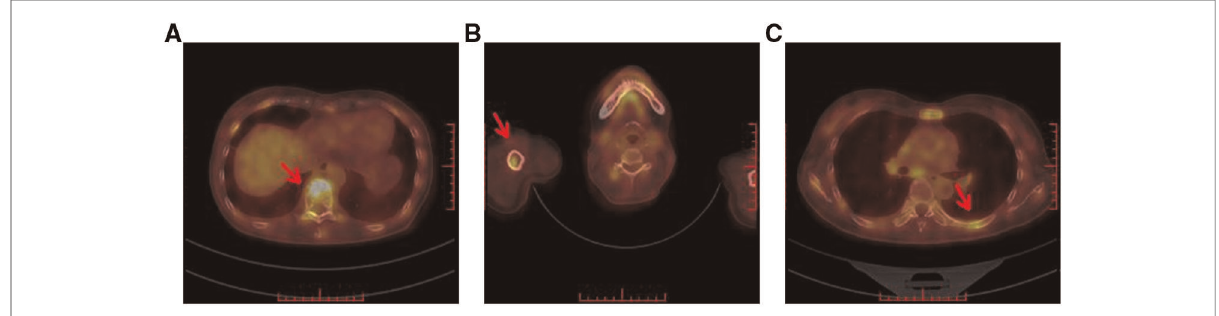
FIGURE 5 Breast molecular imaging fi ndings from a 50-year-old woman with invasive ductal carcinoma with micropapillary features diagnosed with distant bone metastases. PET/CT images show the diffusely increased uptake of 18 F-FDG in the following areas: ( A ) in the spine; ( B ) in the right humerus; and ( C ) in the left ribs (red arrows indicate the locations of metastatic lesions). Abbreviations: PET, positron emission tomography; CT, computed tomography; 18 F-FDG, 18 F- fl uorodeoxyglucose radiotracer.